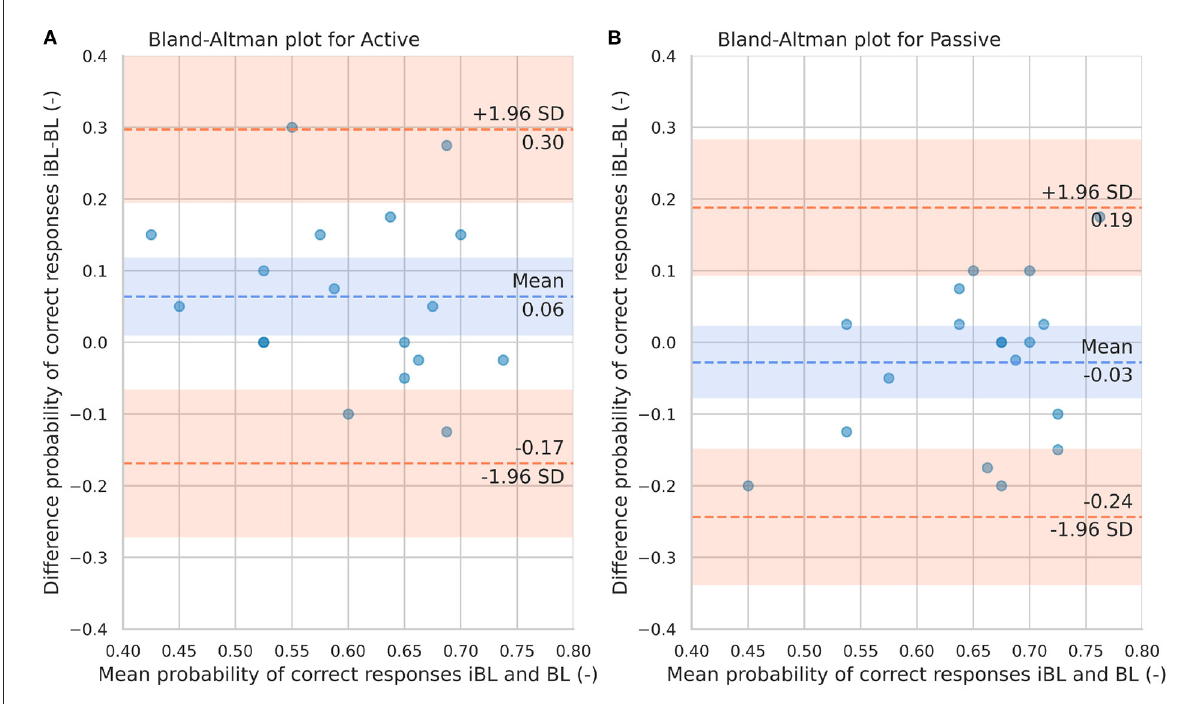
FIGURE7 Bland-Altman plots for the probability of correct responses in iBL and BL for the Active condition (A) and Passive condition (B) . The blue dashed line represents the mean difference between iBL and BL. The lower and upper orange dashed lines represent the lower and upper 95% confidence limits,